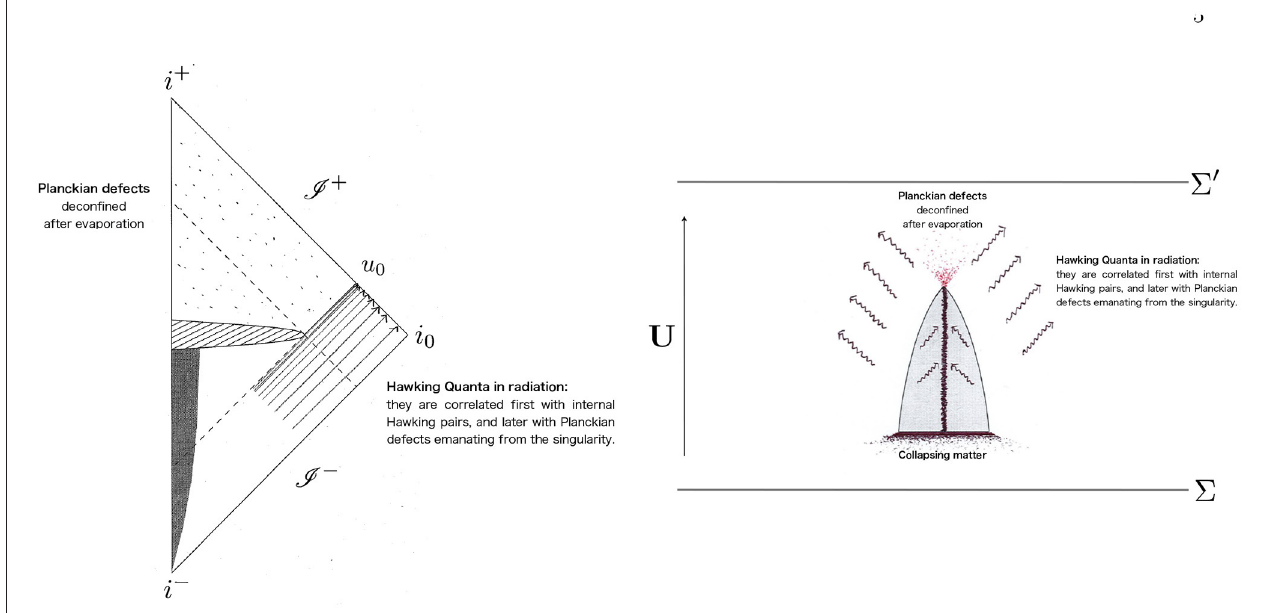
FIGURE 1 | (Left) Penrose diagram illustrating (effectively) the natural scenario, suggested by the fundamental features of LQG, for the resolution of the information puzzle in black hole evaporation ( Perez, 2015). The shaded region represents the would-be-singularity where high fluctuations in geometry and fields are present and where the low-energy degrees of freedom of the Hawking pairs are forced to interact with the fundamental Planckian degrees of freedom. (Right) Same situation as a scattering process from an initial to a final Cauchy hypersurface. This figure contains basically the same information as the Penrose diagram. Its additional merit, if any, is the more intuitive representation of the shrinking black hole as well as the time scales involved (collapse time is very short with respect to the evaporation time). Both these features are absent in the conformal representation on the left. There are limitations to this kind of spacetime representation of a process that is fundamentally quantum and hence only understandable in terms of superpositions of different spacetime geometries.